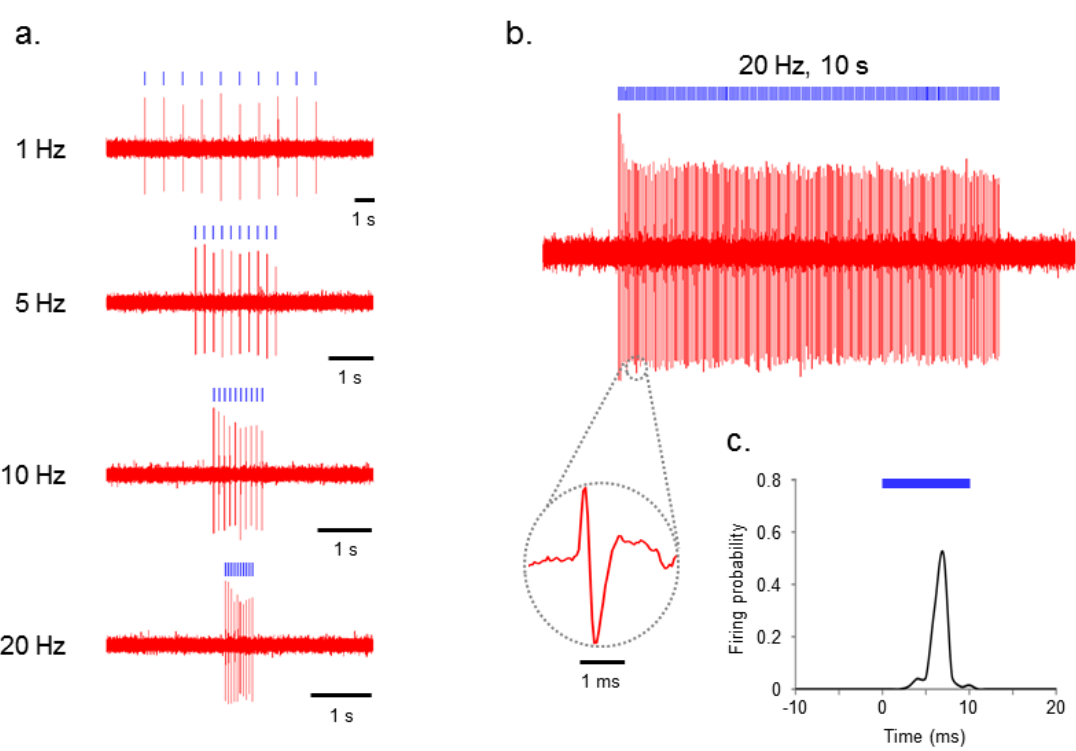
Figure 1. ChR2 evokes temporally precise unit activity in rat PL cortex in vivo . a ) Photoactivation of ChR2-transduced PL neurons at various frequencies (1–20 Hz). b ) Voltage trace showing blue (473 nm) light-evoked spiking of PL neuron to 20 Hz delivery of 10 ms blue light pulses. Inset: representative light-evoked single-unit response. c ) Averaged response of this neuron to 10 ms light pulse calculated from all events in above trace (bin width of 1 ms).